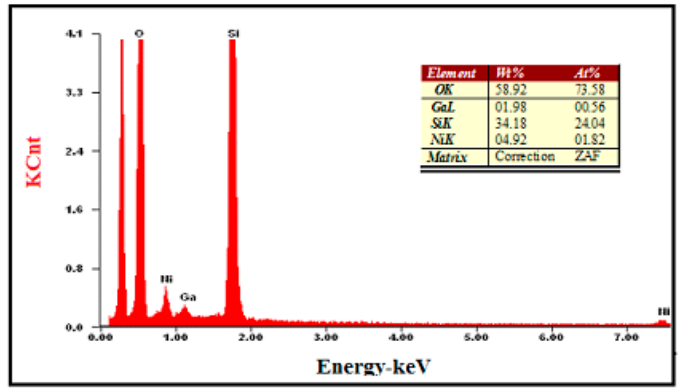
Figure 11. EDX diagram of fresh 5%Ni+2%Ga/MCM-41 catalyst.